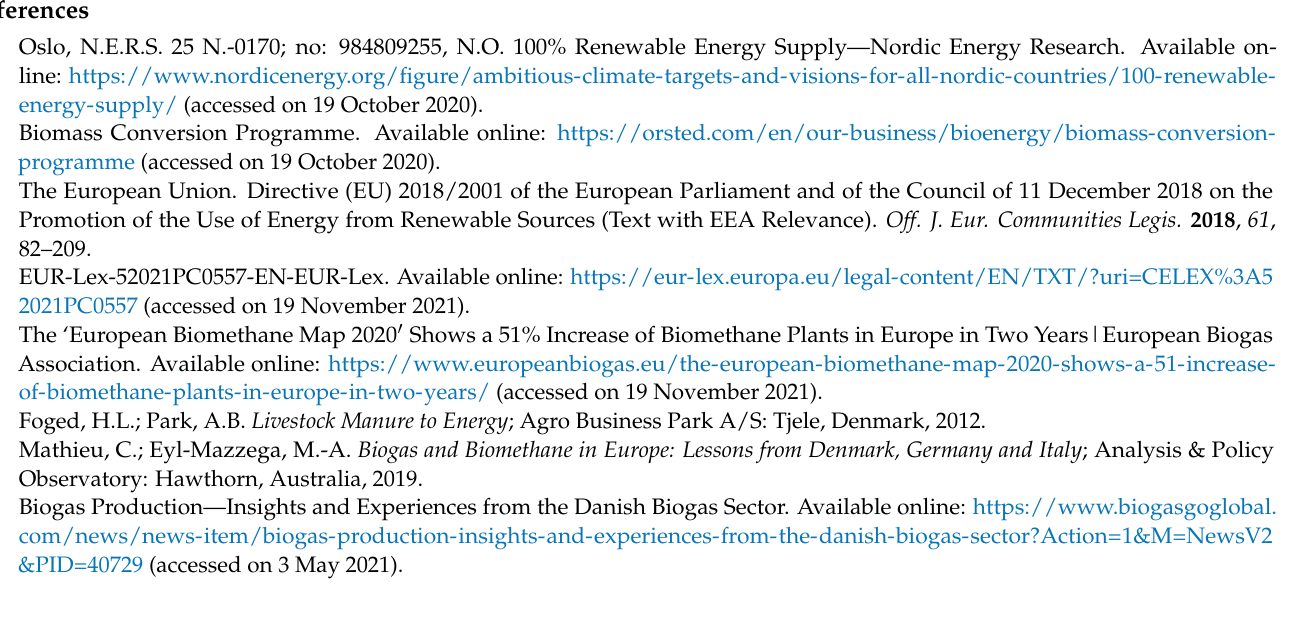
cost for operational expenses, Table S4: Fixed cost calculation factors, Table S5: List of compounds involved in the simulation of the base case design, Table S6: Mass balance for the base case scenario, Table S7: Mass balance for scenario